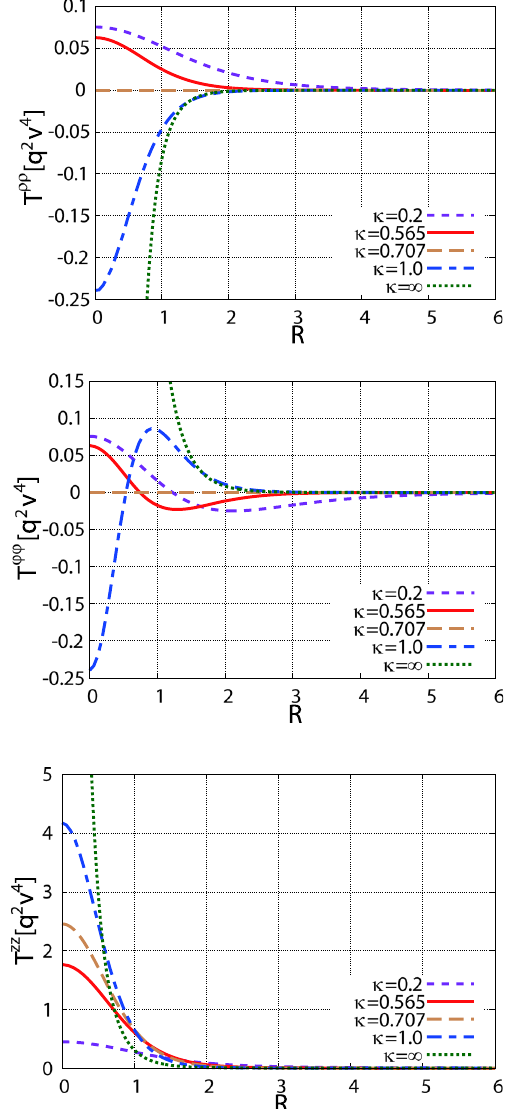
Fig. 9 The components of the stress tensor T μν as functions of R for the n = 1ANOvortexconfigurationintheunitof q 2 v 4 for κ = 1 (type I), 1 √ (BPS), 1 (type II), and ∞ (London limit). The red solid 2 curves represent the stress tensor for the fitted parameter of the GL parameter κ = 0 . 565: T ρρ (top panel), T ϕϕ (middle panel), and T zz (bottom panel)